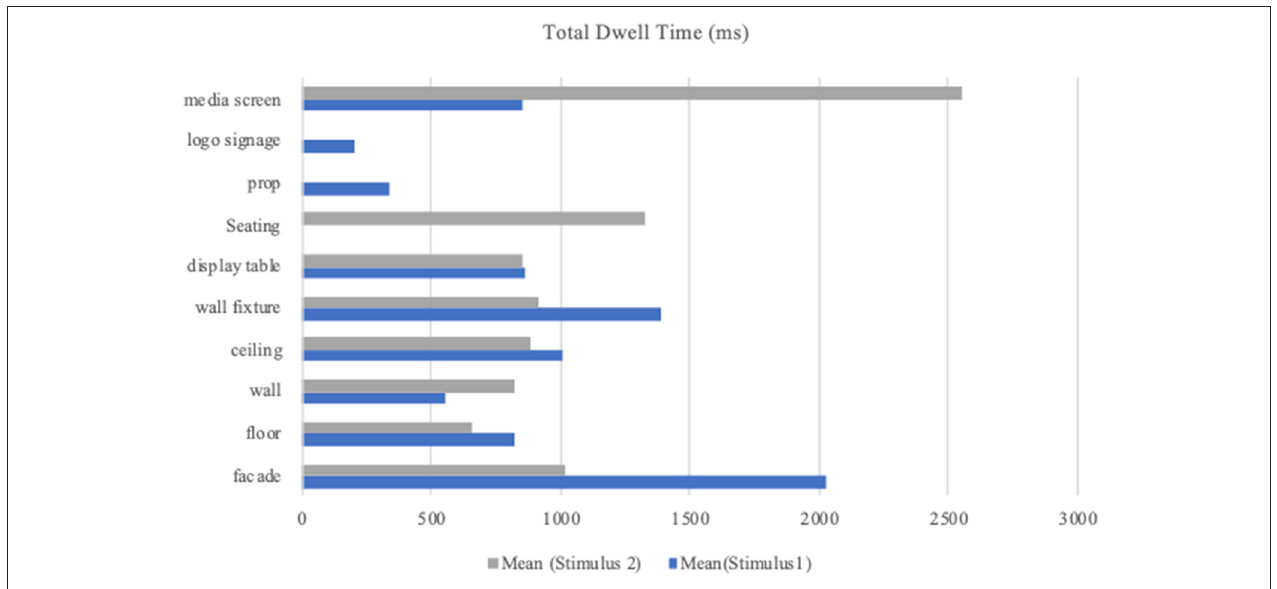
FIGURE 6 | Mean value of total dwell time per